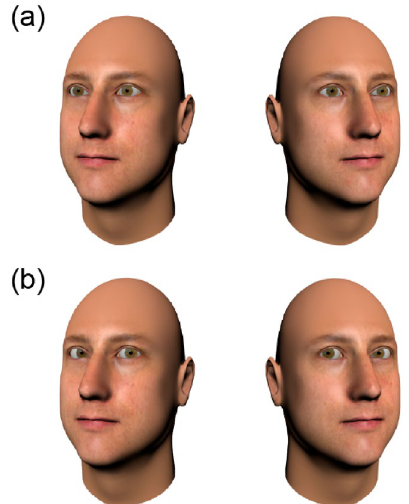
Figure 3. Example of the Standard stimuli. These stimuli have gaze directed away from the viewer ( a ) or towards the viewer ( b ). The eyes in these faces differ in low-level physical cues to gaze direction (e.g., amount and position of visible sclera). The heads and eyes on the top row ( a ) are deviated at an angle of 20° relative to the viewer, whereas the bottom row contains stimuli with heads rotated at 20° and eyes deviated at an angle of 0° relative to the viewer. The face images were generated with FaceGen Modeller 3.5., (https:// faceg en.